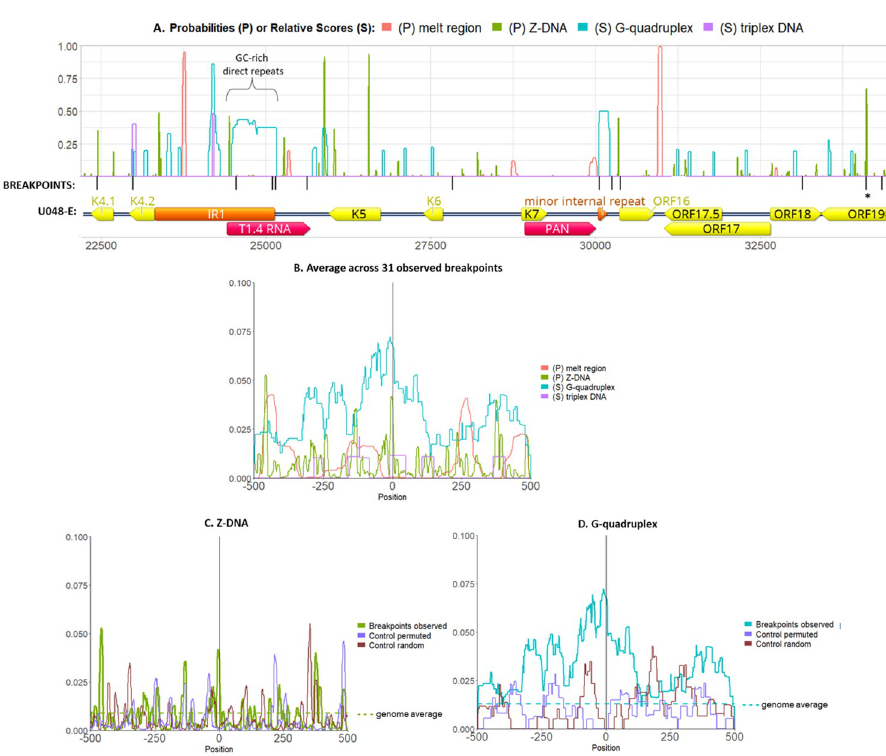
Fig 4. Association of breakpoints to non-B-DNA. The probabilities and relative scores of 4 non-B-DNA structures (local melt region, Z-DNA, G-quadruplex and triplex DNA) were graphed along the genome of KSHV isolate U048-E. Shown is a genome segment including the overrepresented region including K5 and K6. The black ticks mark the breakpoints observed, and below are the annotations for ORFs (yellow), repeat regions (orange) and long non-coding RNAs (red). The asterisk at ORF19 denotes 2 breakpoints 3 bp apart found in 2 different individuals. G-quadruplex scores were normalized to 300, near the human genome maximum (https://pqsfinder.fi.muni.cz/genomes), and triplex scores were normalized to 50, the maximum found. (B.) Probabilities or relative scores were plotted in DNA sequences +/- 500 bp of 31 observed breakpoints (not including those at TR) and averaged across all windows. Score normalizations are as in panel A. Of note, all averages were below 0.10 since probabilities and scores were 0 within most breakpoint windows. (C.) Z-DNA probabilities and (D.) G-quadruplex scores in control permuted sequences and 31 control random windows. The genome-wide averages are shown with the horizontal broken